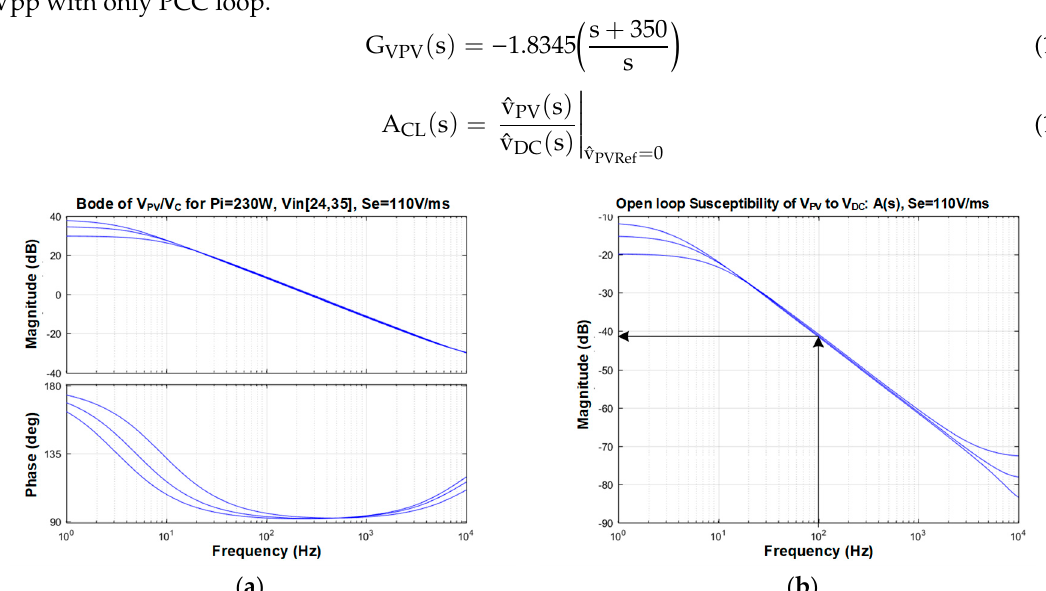
Figure 6. Frequency response of the PCC: ( a ) closed loop ˆv V